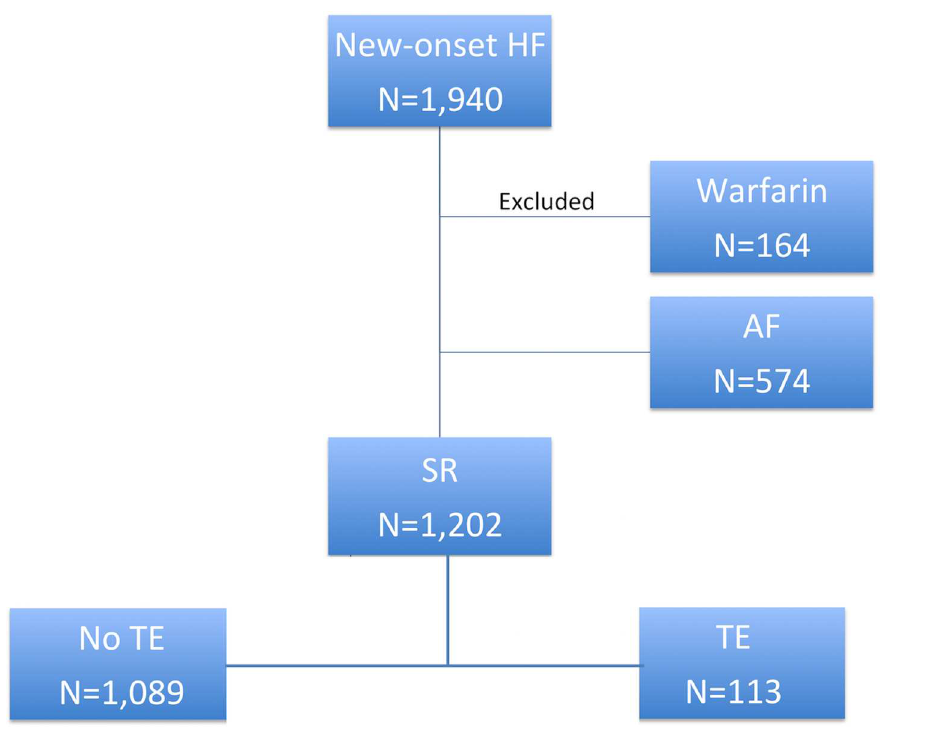
Fig 1. A flow chart showing selection, exclusion and clinical outcomes of our study population. SR– sinus rhythm.